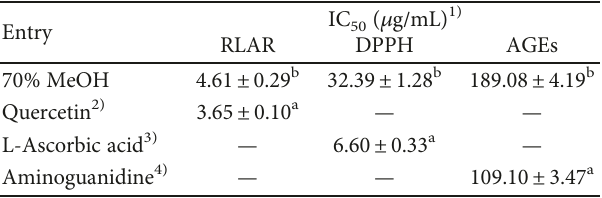
Table 1: The inhibitory activities of MR crude extract on rat lens aldose reductase (RLAR), DPPH radical scavenging, and advanced glycation end products